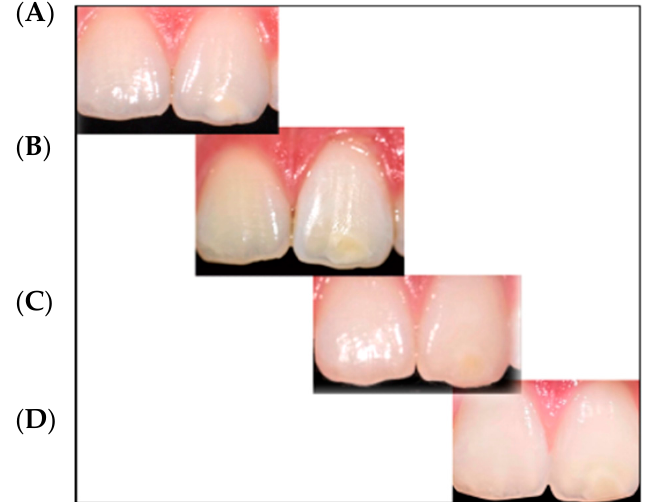
Figure 3. Mild MIH. ( A ) Opacities located on the lateral incisors’ buccal surfaces. ( B ) 24-month follow up.